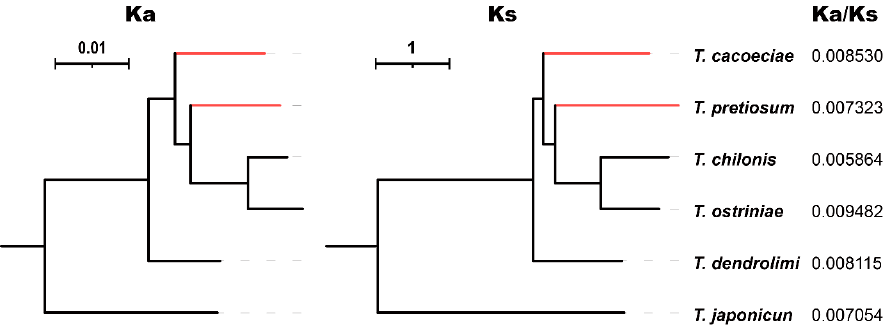
Figure 4. Comparison of Ka/Ks ratios among Trichogramma species. The nonsynonymous substitution rate Ka and synonymous substitution rate Ks were estimated using 13 concatenated mitochondrial protein-coding genes. Red indicates asexual branches, which were tested for relaxed selection. Table 2. Relaxed selection test of asexual branches, T. cacoeciae, and T. pretiosum , compared to sexual branches.